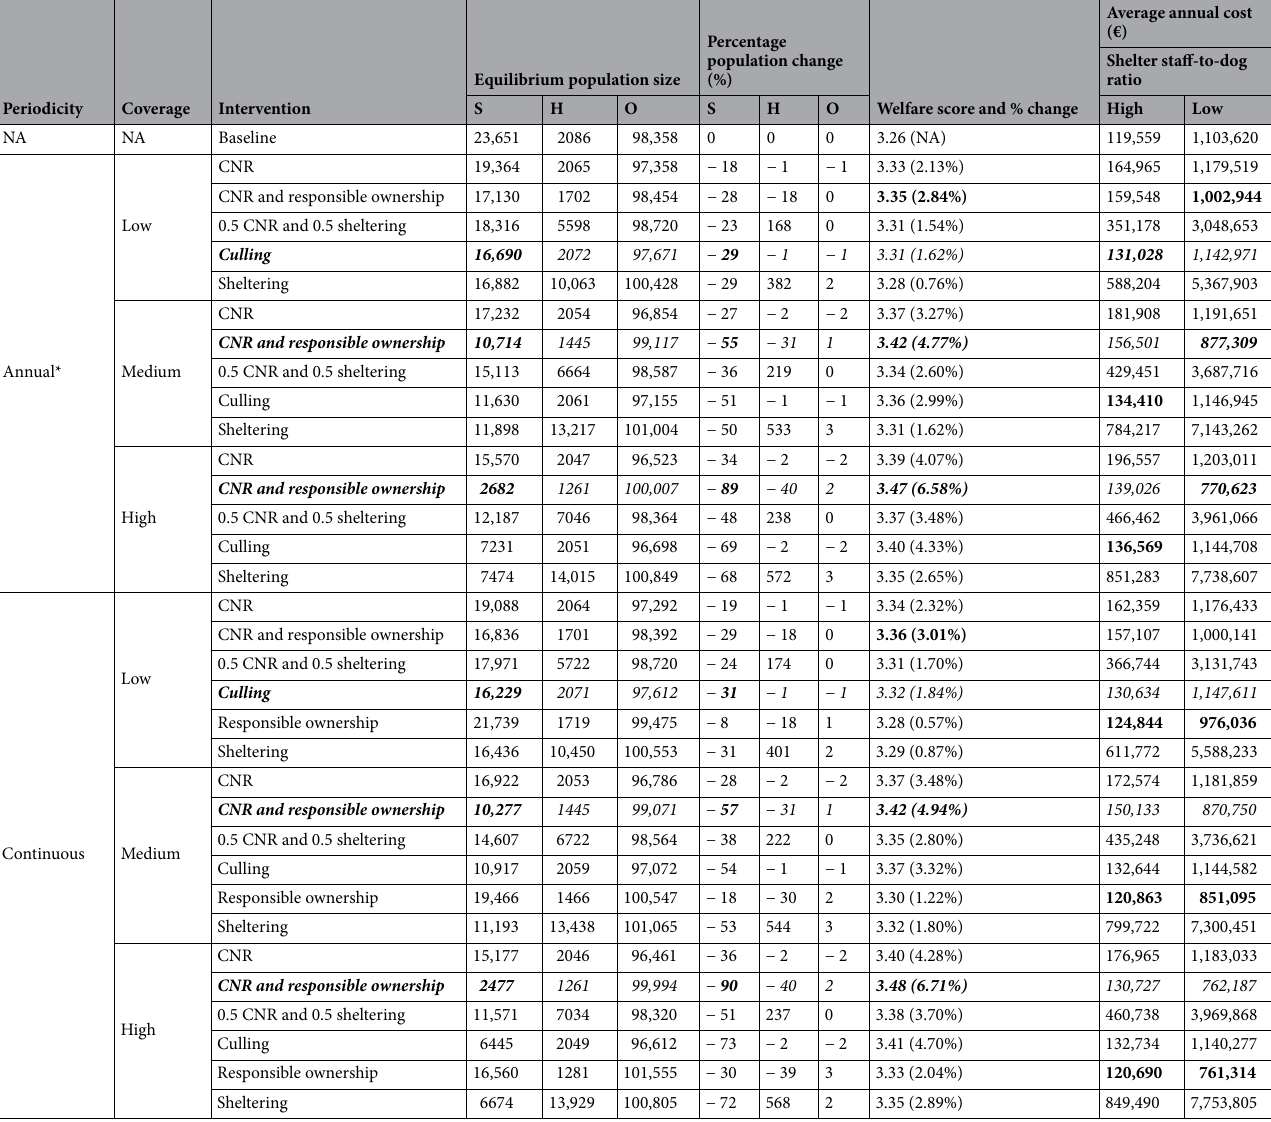
Table 4. Impact of interventions on free-roaming (S), shelter (H) and owned (O) dog population equilibrium levels and percent change from baseline population equilibrium levels for interventions applied for the duration of the simulation at low, medium, and high coverages. The intervention with the greatest reduction in free-roaming dog population size for each periodicity-coverage combination is highlighted in italics. The greatest increase in welfare scores and the lowest average annual costs for each periodicity-coverage combination are highlighted in bold. *As annual interventions did not reach a single stable equilibrium point but varied between two points due to the annual interventions, the average of the minimum and maximum equilibrium population size was